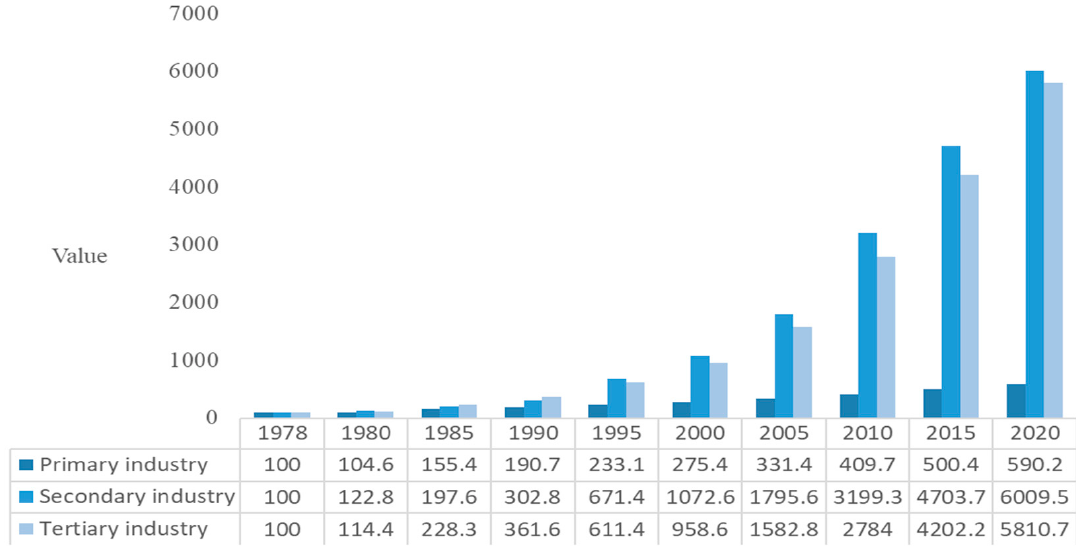
Figure 2. China’s GDP index from 1978 to 2020.